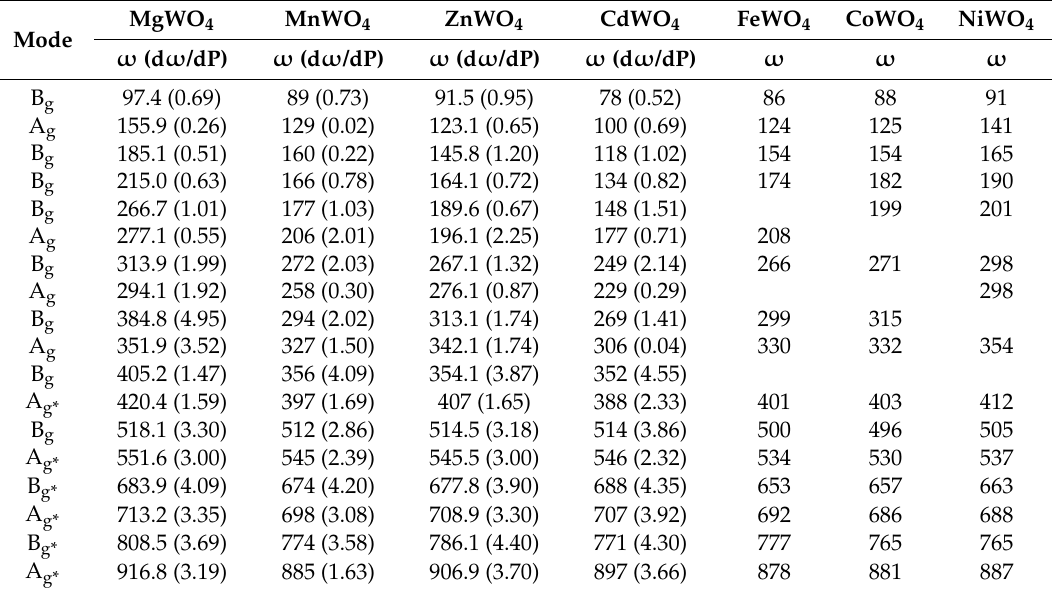
Table 2. Raman frequencies, ω (cm − 1 ), measured in different wolframite-type tungstates [17–20]. The symmetry of the different modes is given. The pressure coefficients, d ω /dP (cm − 1 /GPa), are included in parenthesis for those compounds that are available. The asterisks identify the internal modes of the WO 6